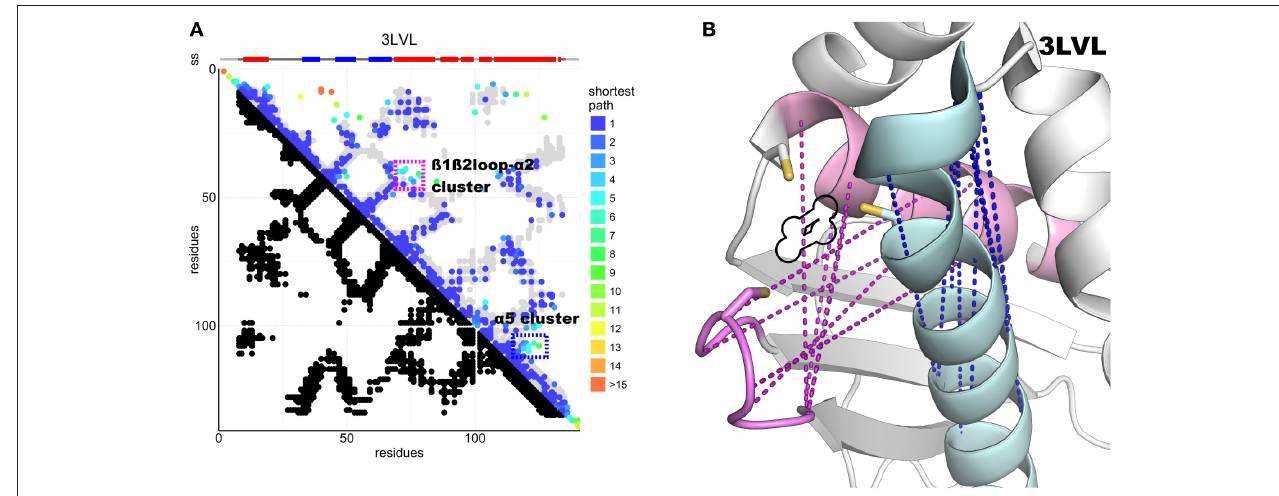
FIGURE 4 | DCA contact map of the IscU protein and structure showing unaccounted contact clusters. (A) DCA on the IscU family compared to the 3LVL structure. The two unaccounted clusters are highlighted by colored frames. (B) FeS cluster-binding site of IscU (3LVL) with the unaccounted contacts between the ß1-ß2 loop and α 2 (pink) and within α 5 (cyan). In purple, the unaccounted loop–helix predicted contacts: in blue, the α 5 cluster. A black outline indicates the location of the FeS cluster in the structure. All the residues involved are at or close to the active site. Cysteine side-chains are shown explicitly.